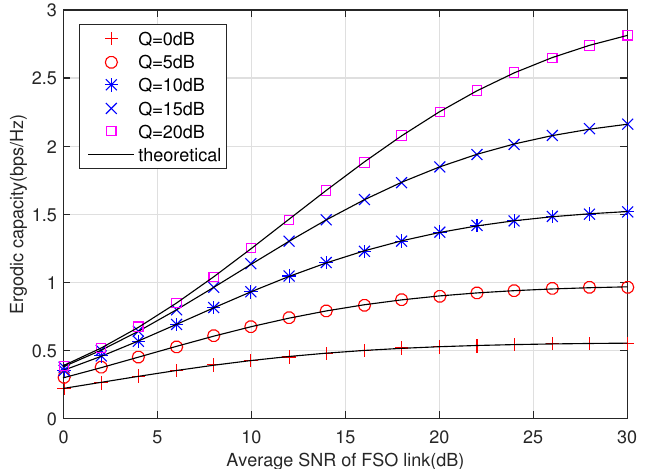
Figure 7. Ergodic capacity under different interference threshold levels with heterodyne detection, where a = 2.064, b = 1.342 and ξ = 1.1.